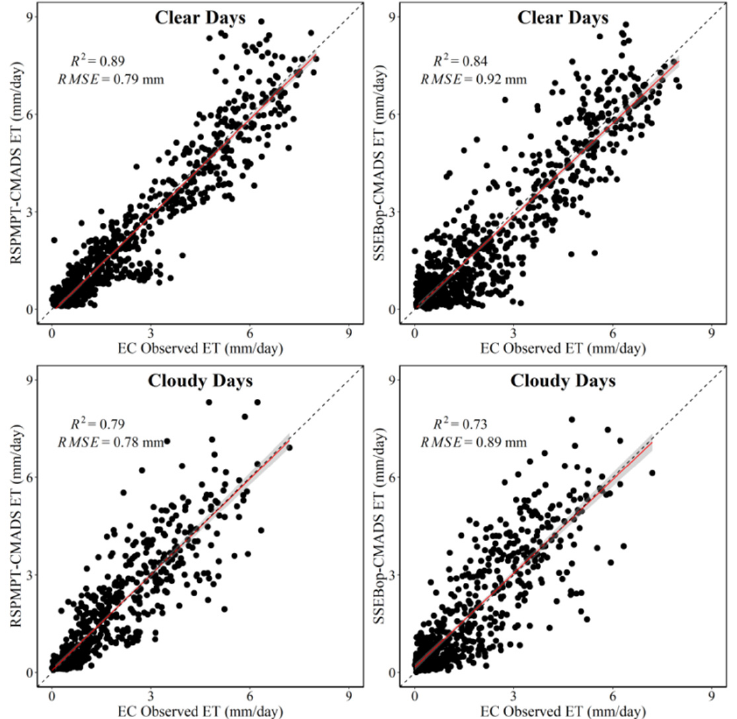
Figure 6. The scatter plots for the two methods (RSPMPT-CMADS and SSEBop-CMADS) estimated ET versus EC observed ET on clear and cloudy days.